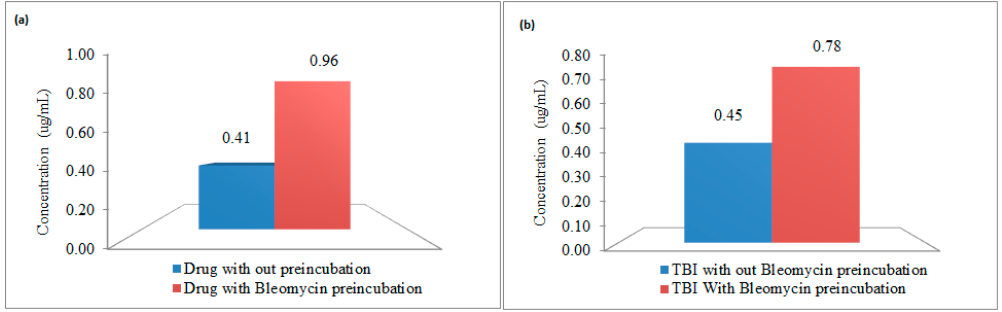
Figure 3. Chelation effect of Bleomycin in in-vivo samples. Nanomaterials 2018 , 8 , x FOR PEER REVIEW